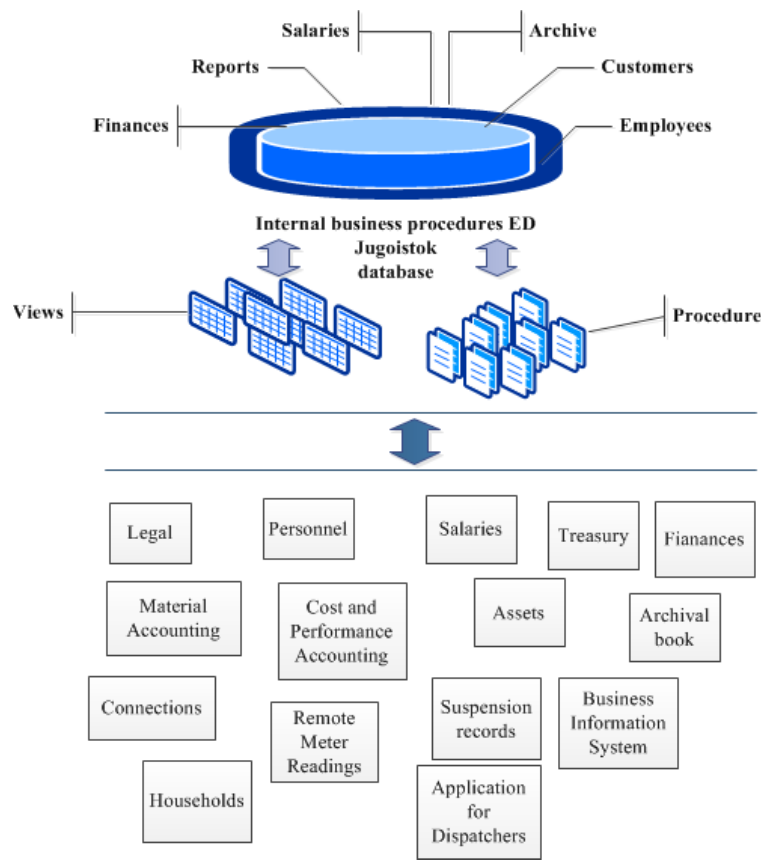
Figure 1. ED Jugoistok Information System: internal data exchange between applications that implement internal business procedures but are not directly